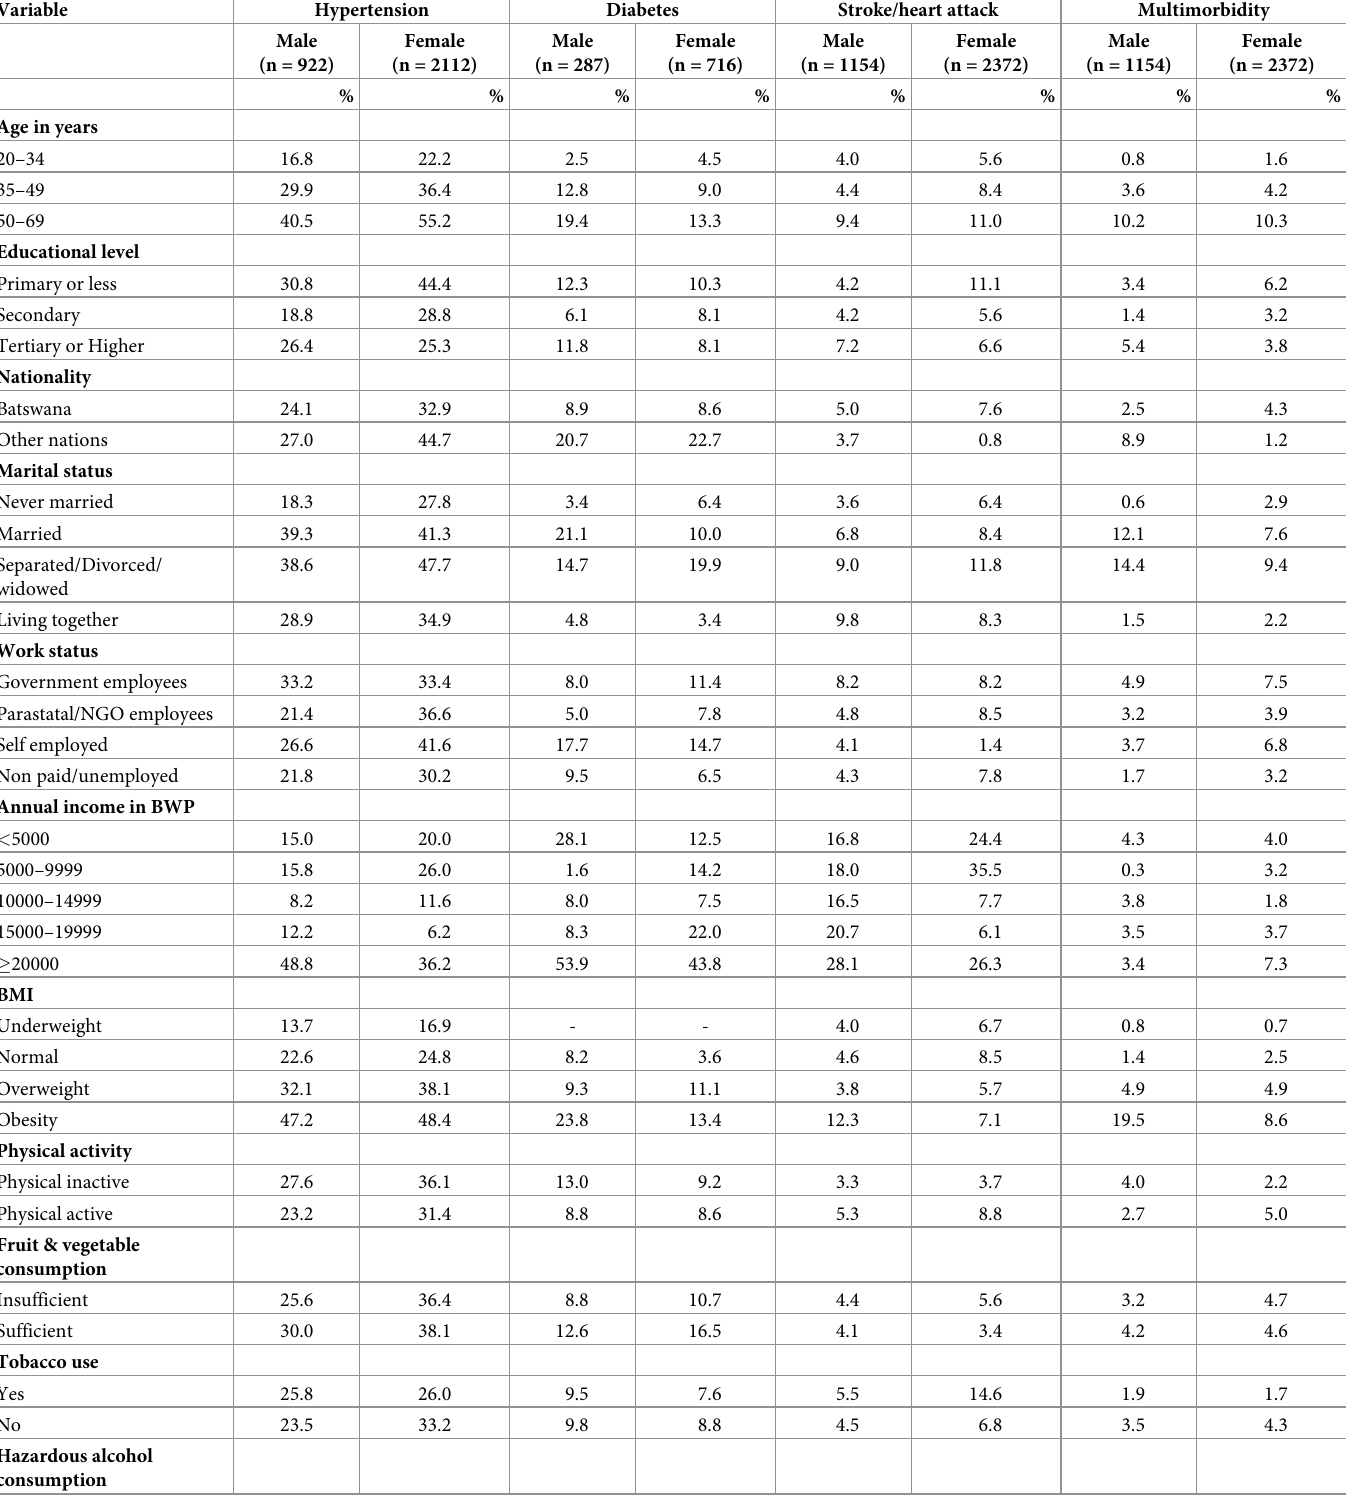
Table 2. Prevalence and patterns of hypertension, diabetes, stroke/heart attack and multimorbidity stratified by sex.